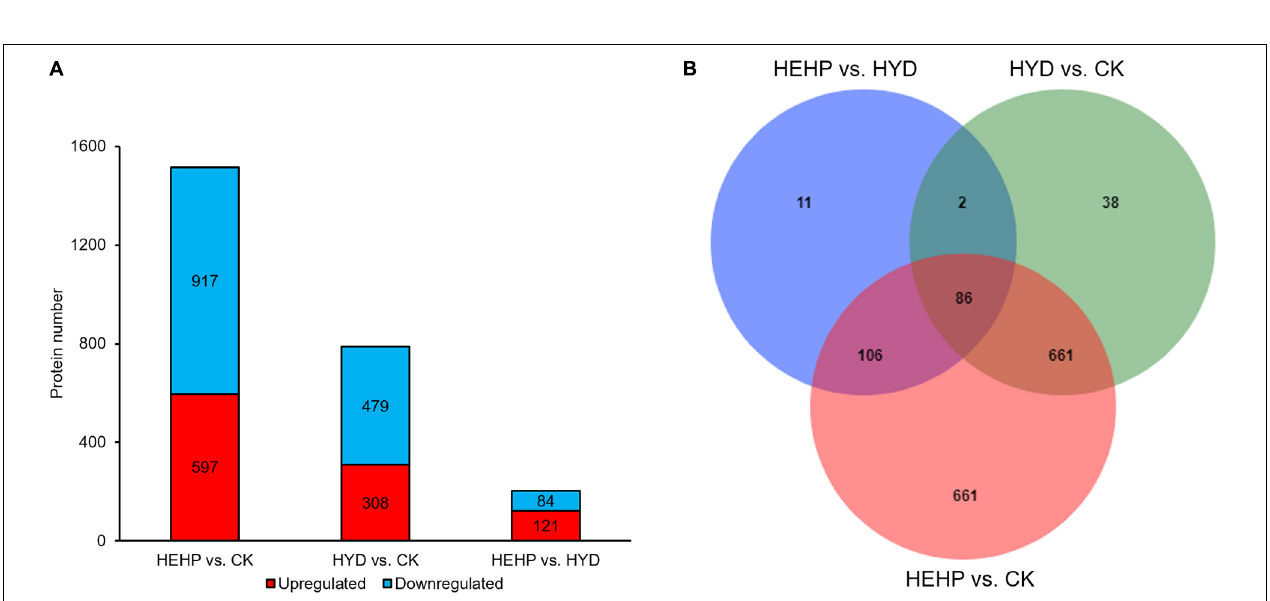
FIGURE 3 | Statistics of DAPs. (A) The number of DAPs among the three groups. (B) Venn diagram showing specific and overlapping DAPs among the three groups.